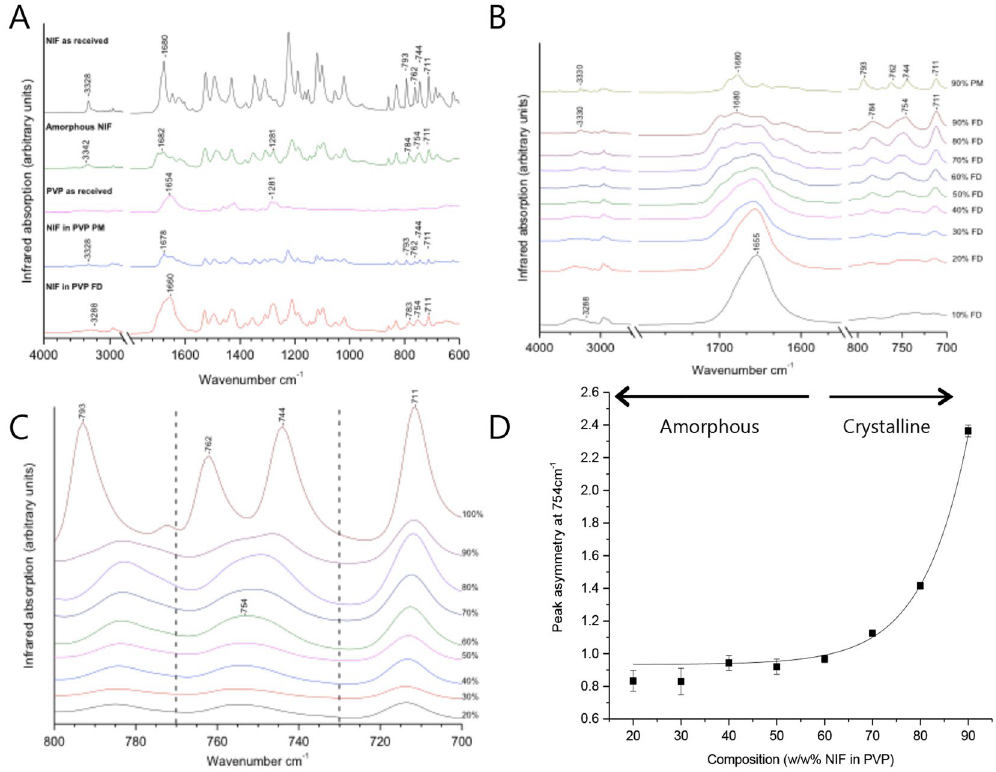
Figure 5. ( A ) FT-IR spectra of crystalline nifedipine as received, amorphous nifedipine (produced by heat melt), PVP as received, 50% w/w crystalline NIF in PVP as physical-mix (NIF in PVP PM) and Freeze-dried 50% w/w NIF in PVP (NIF in PVP FD). FT-IR measurements were repeated to ensure data reproducibility (n = 3). ( B ) N-H (3288–3330 cm − 1 ), Carbonyl (1660–1680 cm − 1 ) and out of plane δ (C-H) vibration of the ring (800–700 cm − 1 ) regions of the FT-IR spectrum for the full range of freeze-dried NIF in PVP formulations compared to the 90% w/w NIF in PVP physical-mix of crystalline NIF in PVP. All percentages listed are of NIF in PVP. FT-IR measurements were repeated to ensure data reproducibility (n = 3). ( C ) FT-IR spectra (800–700 cm − 1 only) of freeze-dried formulations 20–100% w/w NIF in PVP. Peak symmetry change at 754 cm − 1 (peak distinctive of amorphous nifedipine) was examined. 90% w/w NIF shows a clear left shoulder. FT-IR measurements were repeated to ensure data reproducibility (n = 3). Spectra presented in ( A ), ( B ) and ( C ) where corrected for baseline using the software PerkinElmer spectrum 10. Additionally spectra presented in ( B ) & ( C ) had a PVP spectrum subtraction. ( D ) Monitoring NIF crystallinity in freeze-dried formulations using FT-IR peak symmetry at 755 cm − 1 . A change in peak symmetry is indicative of a change in physical state, as amorphous NIF presents a single broad and asymmetric peak at 754 cm − 1 and crystalline NIF presents 2 separate peaks at 762 cm –1 and 744 cm − 1 , the gradual change from the broad amorphous peak to the double crystalline peaks can be quantitatively measured through peak symmetry measurements. Error bars represent standard error of n =